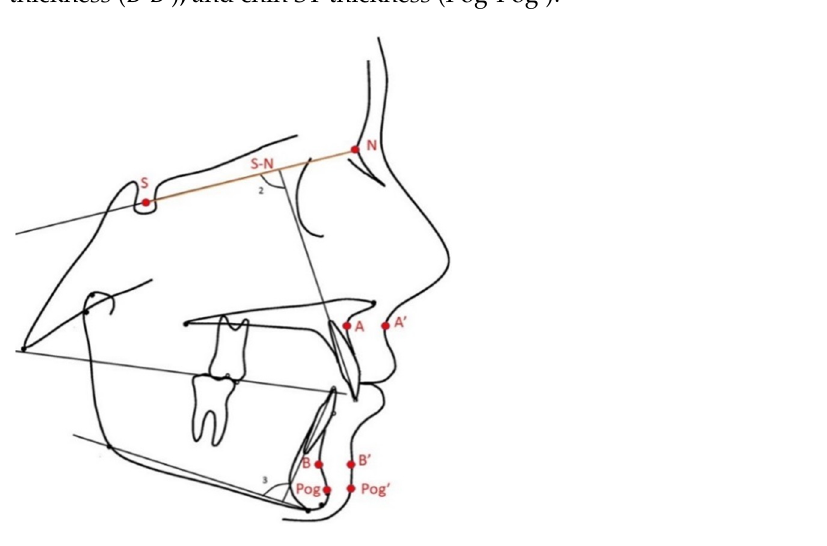
Figure 1. Lateral cephalometric X-ray measuring points. Abbreviations: S—Sella Turcica, N—Nasion, A—Hard tissue A point, A’—Soft tissue A point, B—Hard tissue B point, B’—Soft tissue B point, Pog—Hard tissue pogonion, and Pog’—Soft tissue pogonion.